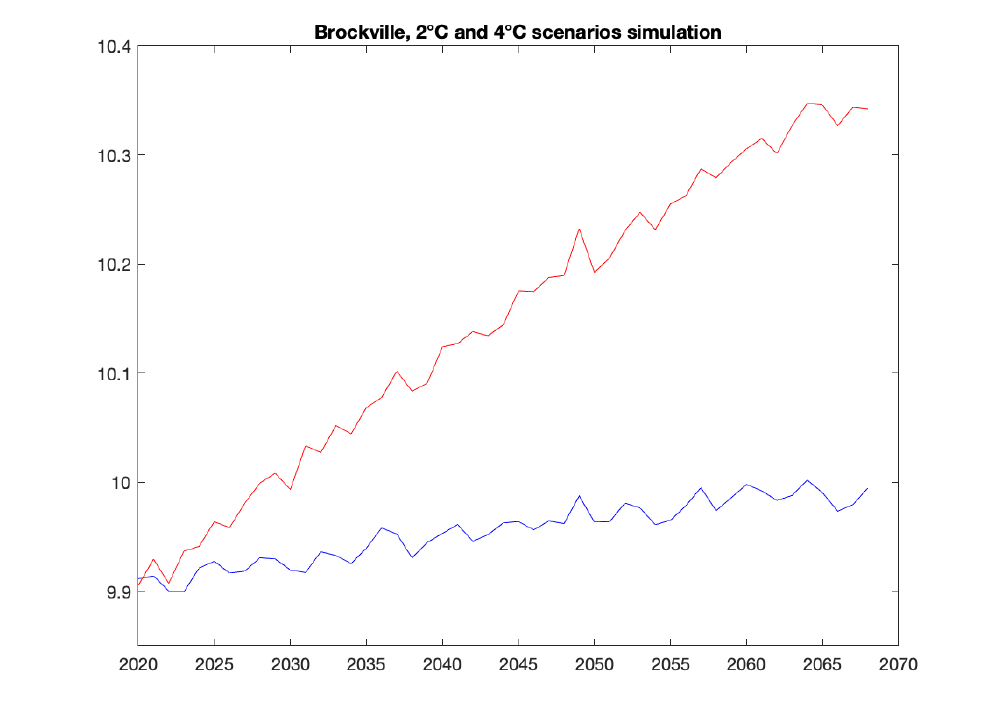
Figure 1. Simulated average corn yield (tons per hectare) between 2020 and 2068 for Brockville under a +2 ◦ C (blue) and +4 ◦ C (red) warming scenario.